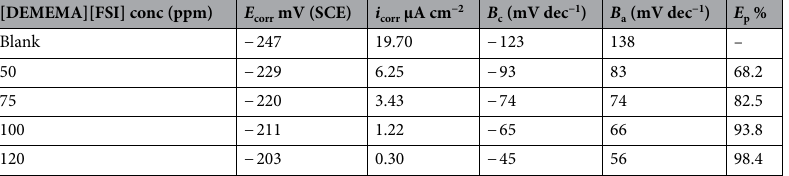
Table 1. Polarization parameters and corresponding inhibition efficiency for Cu–Ni alloy in (3.5% NaCl + 10 ppm sulfide) solution in the absence and presence of [DEMEMA][FSI] at 298 K.